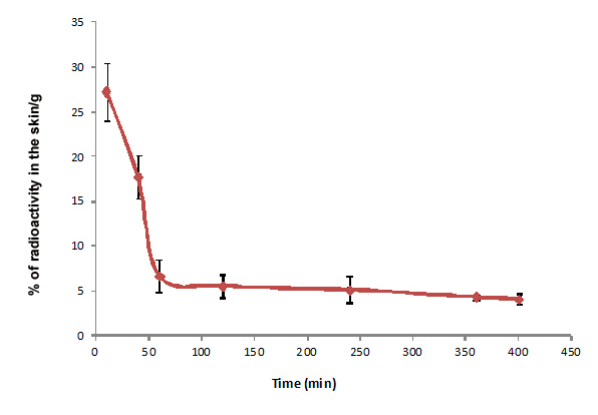
Figure 2. Distribution of H. lepturus venom in the skin after subcutaneous injection in rats . Values are the averages obtained from three rats in each group. The times shown represent intervals following venom administration ( 125 I-labeled 10 µg venom per rat).